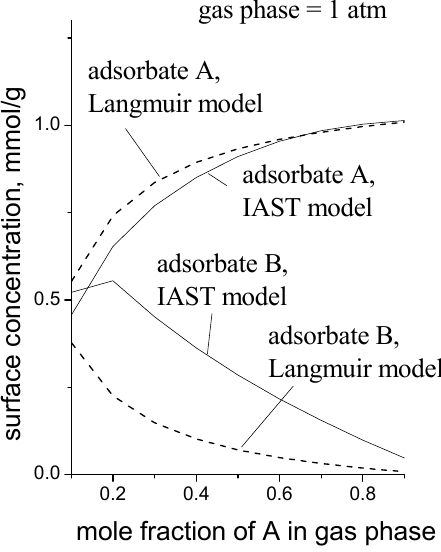
Figure 6. Type 1 site surface concentrations in a mixture as a function of the gas phase composition calculated by the multicomponent Langmuir isotherm and the IAST for adsorption on Type 1 and Type 2 dual